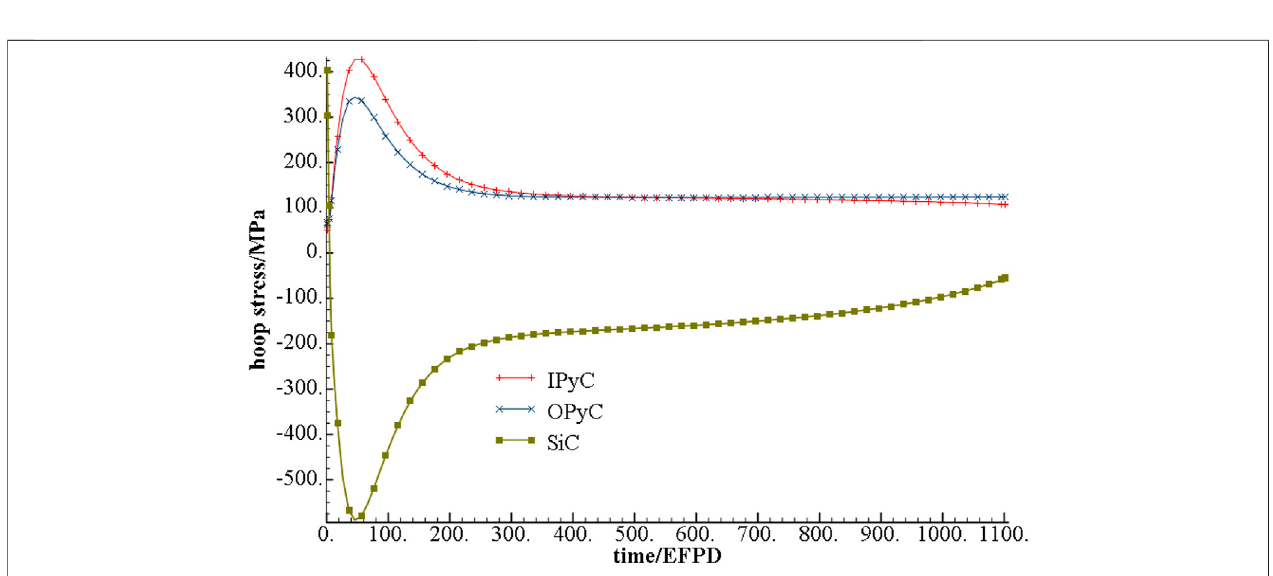
FIGURE 11 | Hoop stress of the PyC layer and SiC layer variation with EFPD under power transient condition.